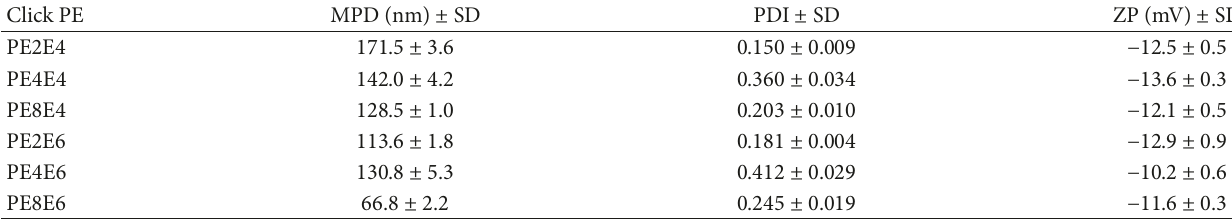
Table 14: The MPD, PDI, and ZP of prepared NPs ∗ .